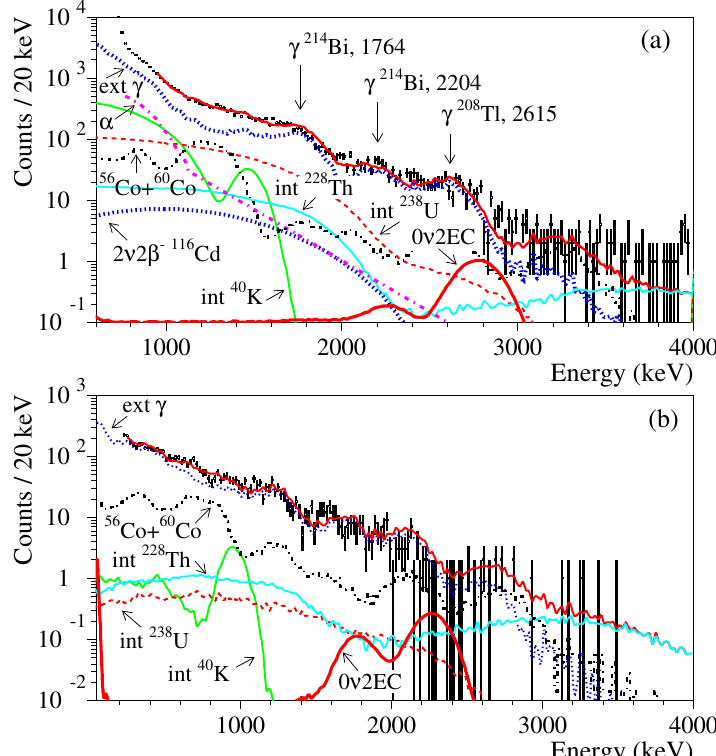
Figure 7. Energy spectra of the γ and β events accumulated for 26,033 h by the 106 CdWO 4 scintillation detector in anti-coincidence with the CdWO 4 counters ( a ) and in coincidence with the 511 keV annihilation γ quanta in at least one of the CdWO 4 counters ( b ) (points) together with the background model (red line). The main components of the background are shown: the distributions of internal contaminations (“int 40 K”, “int 232 Th”, and “int 238 U”) and external γ quanta (“ext γ ”), residual α particles in the 106 CdWO 4 crystal ( α ), cosmogenic 56 Co and 60 Co in the copper shield details, and the 2 ν 2 β decay of 116 Cd. The excluded distributions of the 0 ν 2EC decay of 106 Cd to the ground state of 106 Pd with the half-life T = 6.8 × 10 20 yr are shown by red solid 1/2